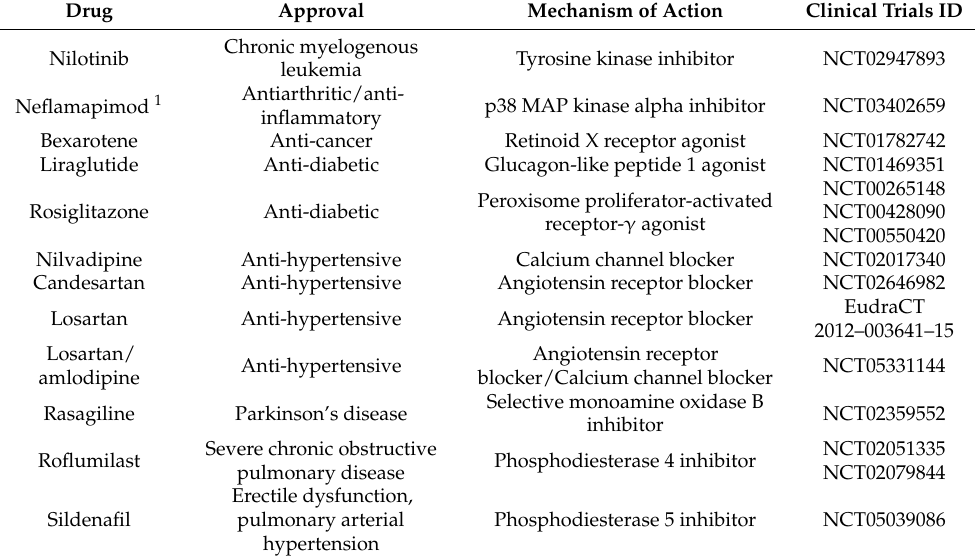
Table 2. The representatives of clinical trials of drugs considered for repurposing in